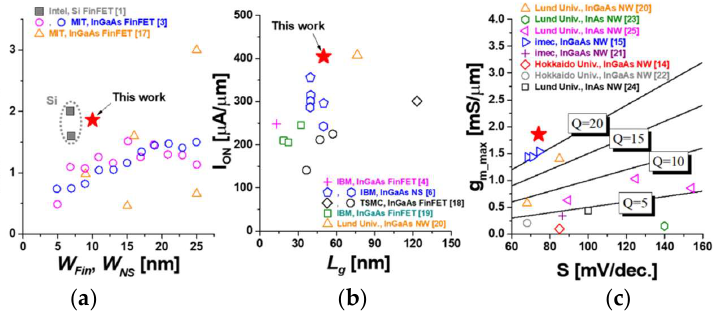
Figure 6. Benchmark of ( a ) g m_max vs. minimum dimensions ( W Fin or t NS ), ( b ) I ON vs. L g and ( c ) g m_max vs. S against those of other groups’ non-planar In x Ga 1-x As MOSFETs.